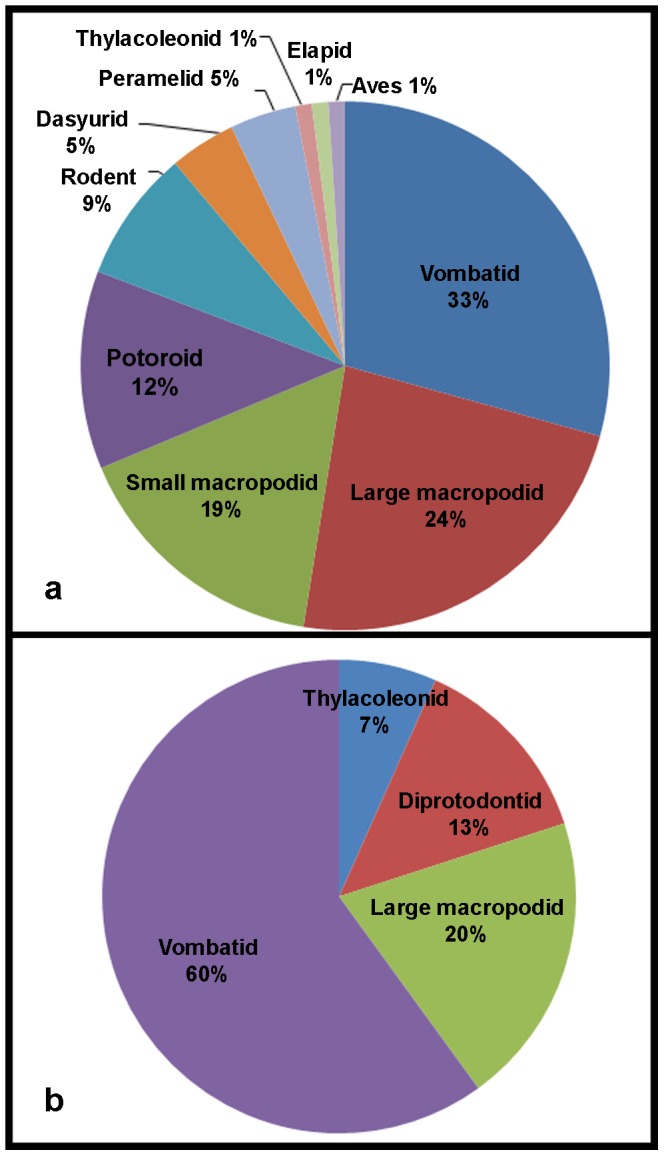
Proportional representation of taxa by trace and body fossils.Proportions of organisms represented by body (skeletal) fossils (a) and trace (footprint) fossils (b).